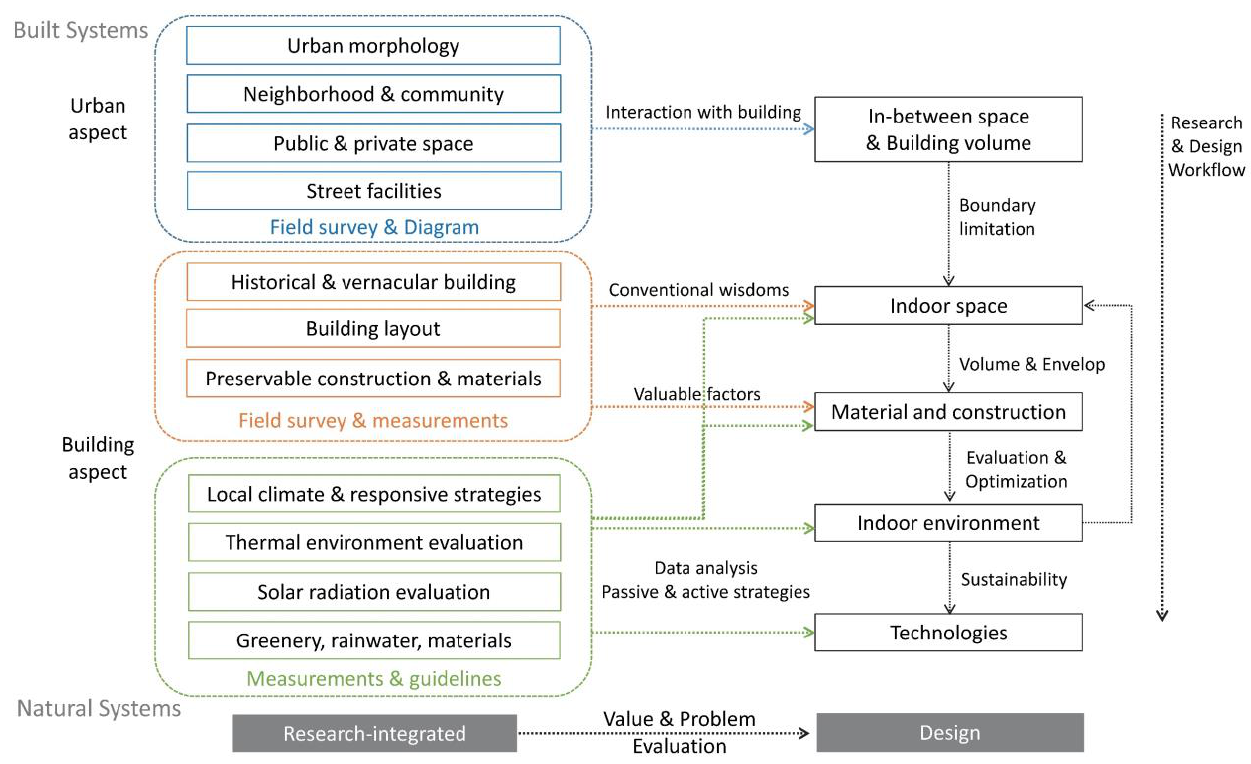
Figure 2. Structure of the program .